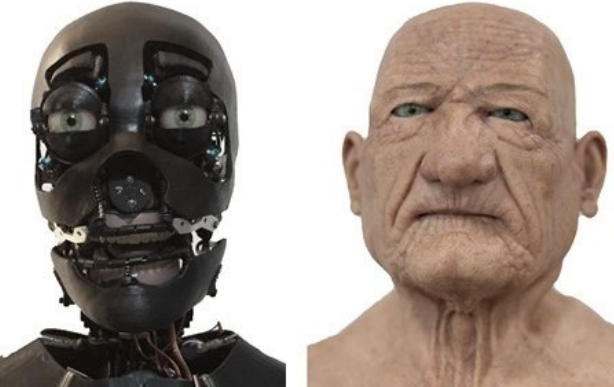
Figure 12. Realistic Humanoid Robot Euclid with non-dilating acrylic Eyes. Left : exoskeleton. Right : RHR with skin .